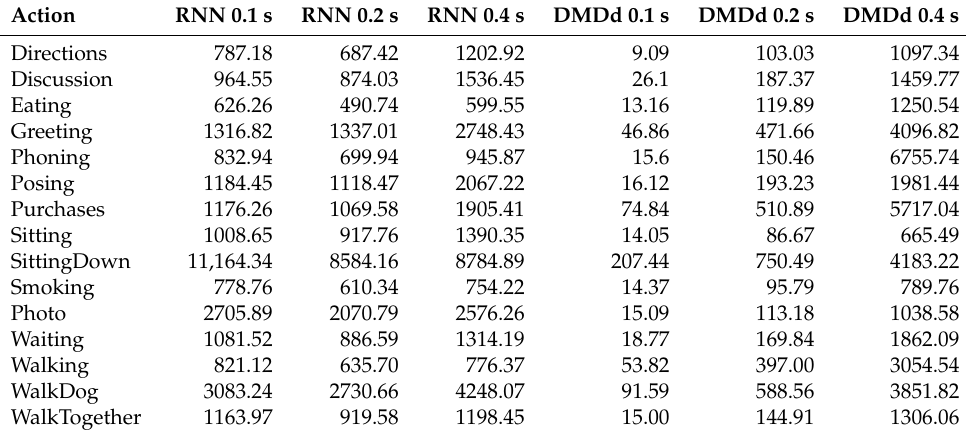
Table 1. Comparison of anticipation error using a RNN and Dynamic Mode Decomposition with 80 delays for various anticipation times. The error measure is the mean squared error of 17 markers on the pose sequences for anticipation times of 0.1s (5 frames), 0.2s (10 frames), and 0.4s (20 frames) on the different motion classes of the Human 3.6M dataset for actor #5. The squared errors are expressed in mm 2 , but notice that the error is measured in R 3 · 17 .